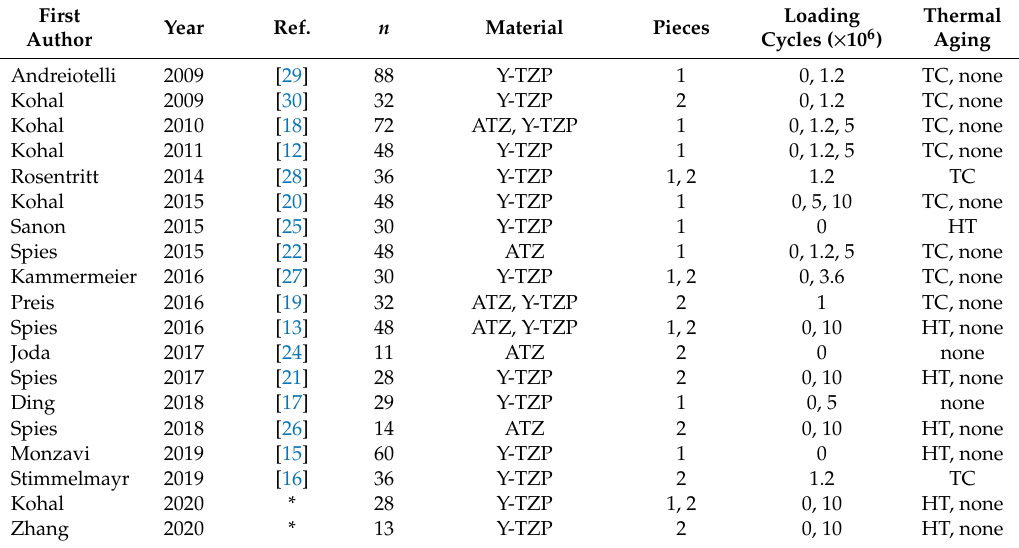
Table 1. A total of 731 one- and two-piece implants made from yttria-stabilized tetragonal zirconia polycrystal (Y-TZP) and alumina-toughened zirconia (ATZ), extracted from 17 studies and two unpublished datasets, subjected to di ff erent dynamic loading and thermal aging conditions prior to static loading to fracture, were finally included in meta-analyses.